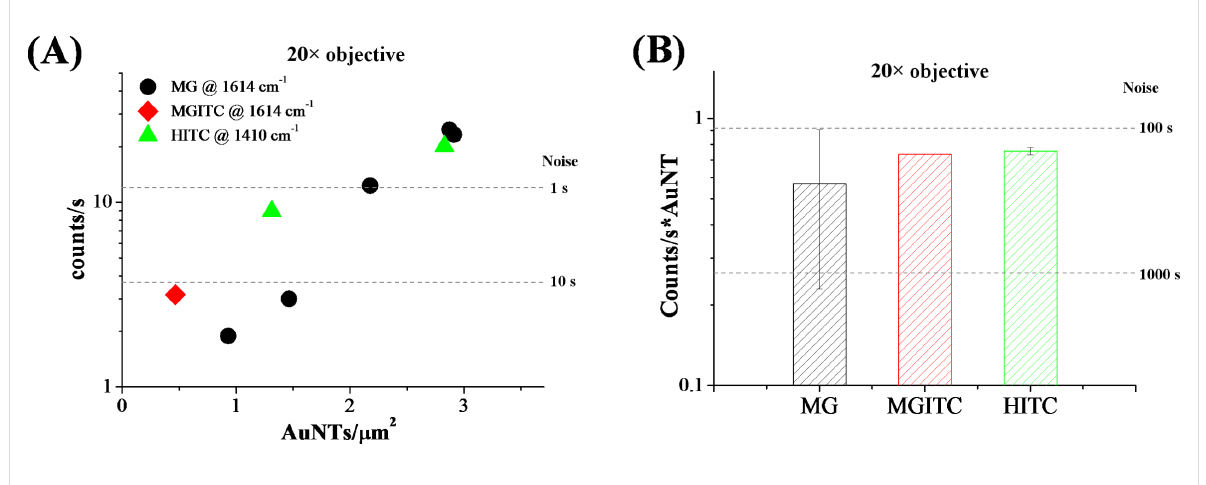
Figure 4: Results for Raman analysis with the 20× objective: (A) Counts per second versus AuNT surface density for MG (black circles), MGITC (red diamonds) and HITC (green triangles) labels. Each point in the graph corresponds to a different point on the TEM grid. (B) Mean value of the counts per second for a single AuNT. Error bars represent the standard deviation. Dashed lines represent twice the noise level in the experimental condi- tions used and for various acquisition